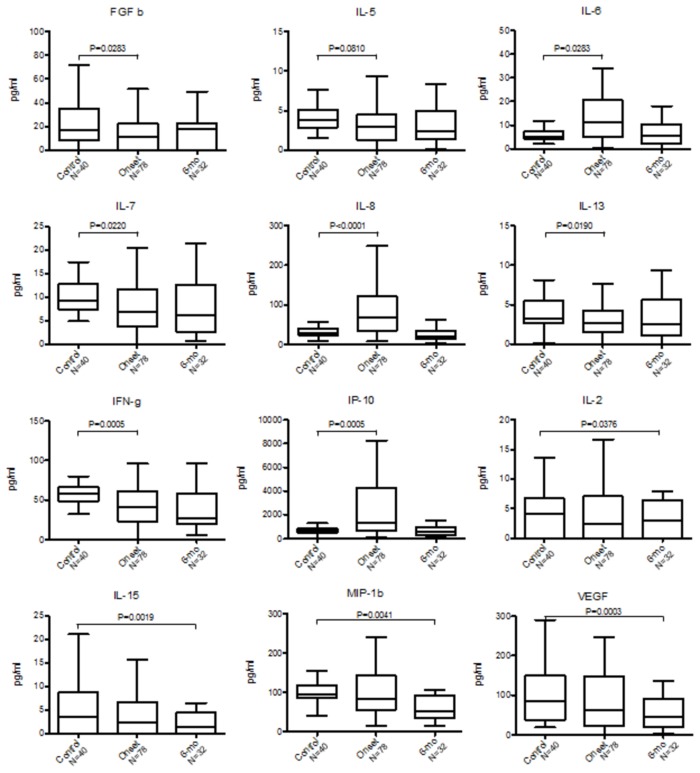
Immune analytes concentrations differentially distributed between control, DILI onset or 6-month follow up samples.Box-and whisker plot: Turkey representation (i.e. 25-75 percentile +/- 1.5 interquartile distance) of immune analytes concentration in sera collected from control, DILI onset and 6-month follow up. Immune analytes measurements are in pg/mL. * Comparisons of DILI onset or 6-month follow up distribution to control samples are statistically significant (p<0.05) by Wilcoxon rank sum test. § Comparisons of the difference between DILI onset and 6-month follow up distributions are statistically significant (p<0.05) by paired t-test or Wilcoxon rank sum test.